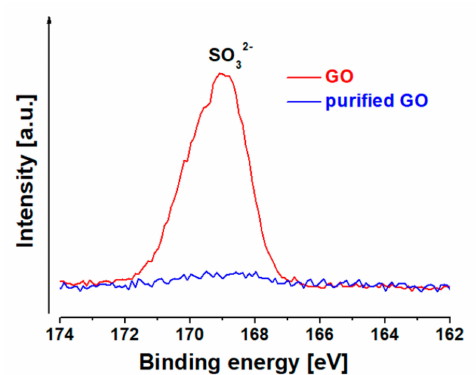
Figure 3. X-ray photoelectron spectroscopy S2p region spectra of graphene oxide (red) and purified graphene oxide